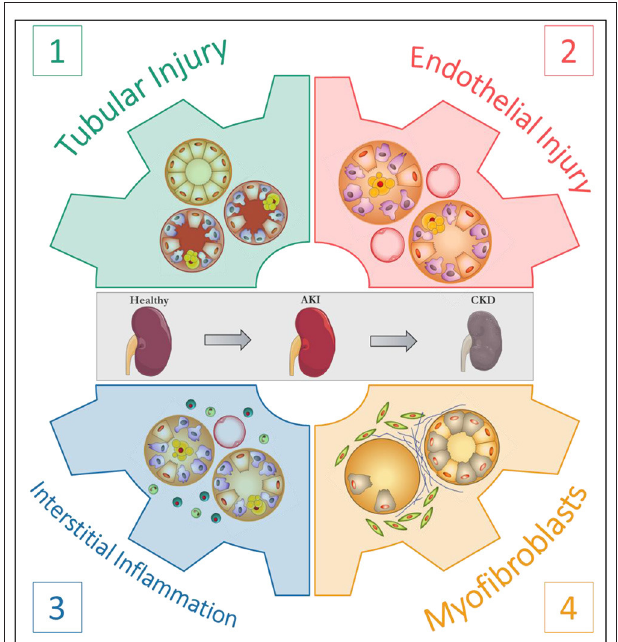
FIGURE 1 | The four pivotal cellular responses in the progression of kidney disease. According to Eddy